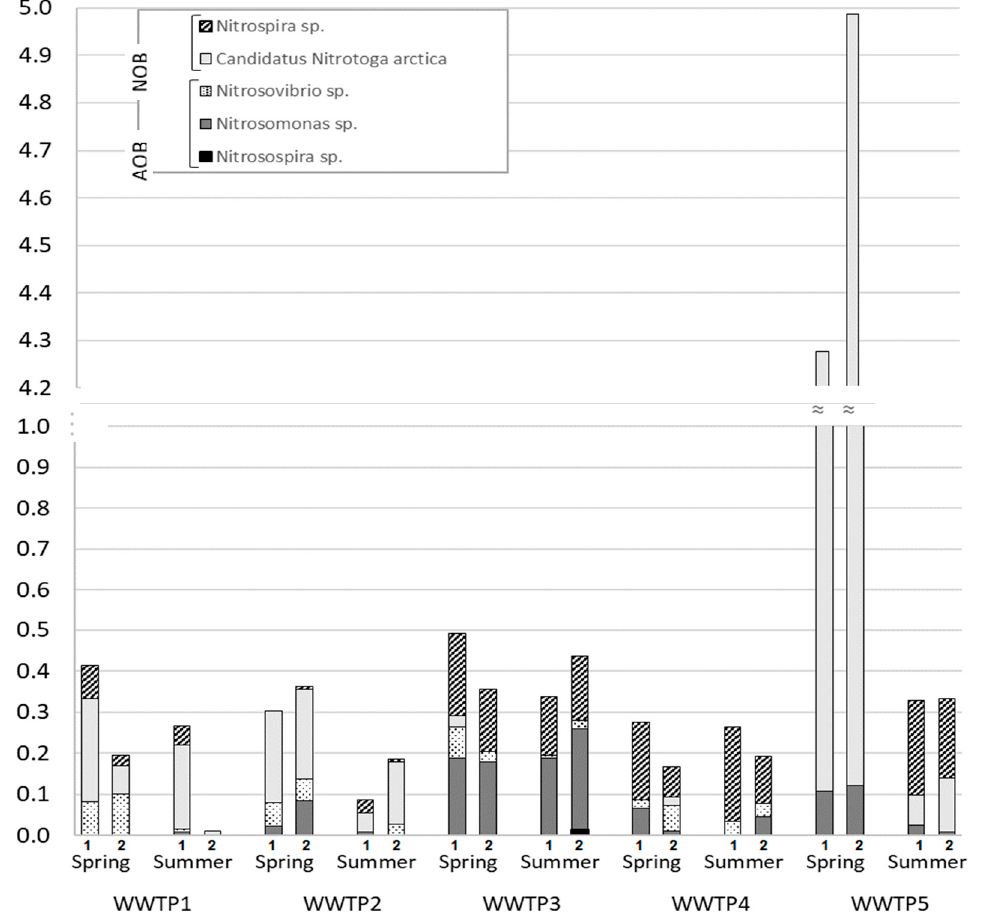
Figure 4. Relative abundance of nitrifying bacteria in studied WWTPs.